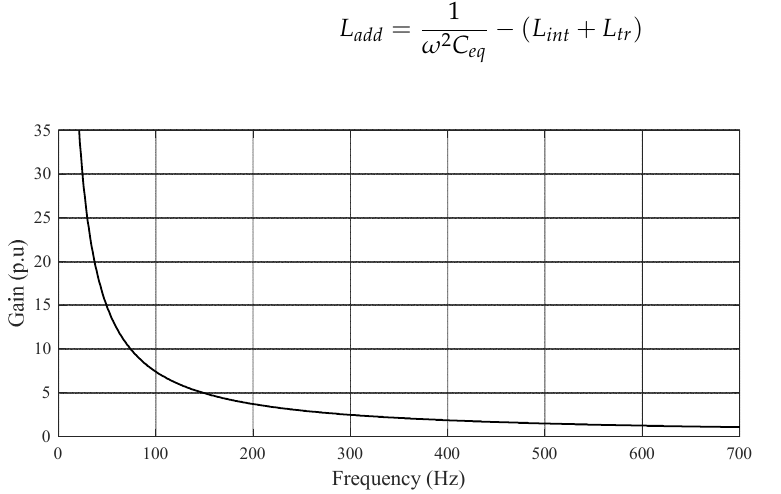
Figure 13. The transfer function gain versus the required frequency.